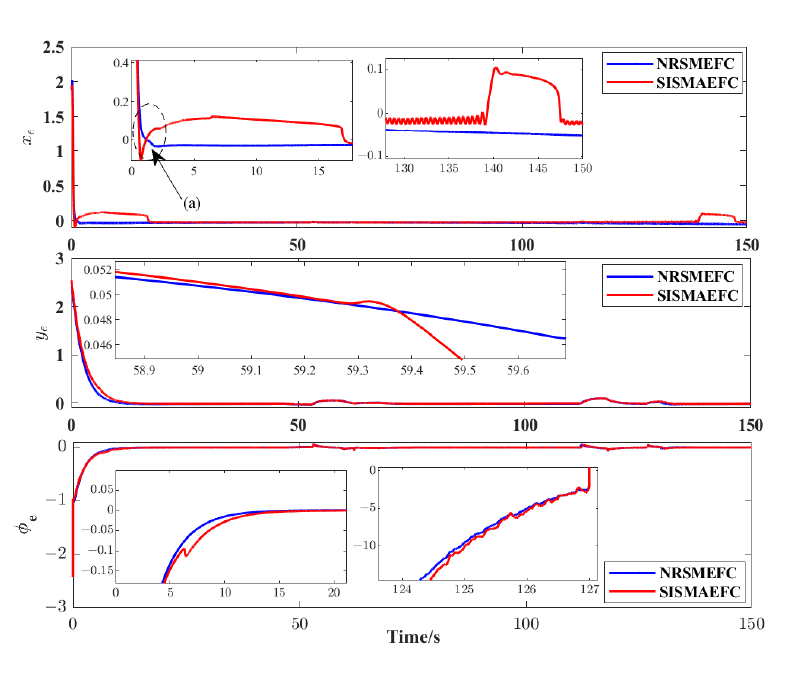
Figure 7. Comparison of system error.